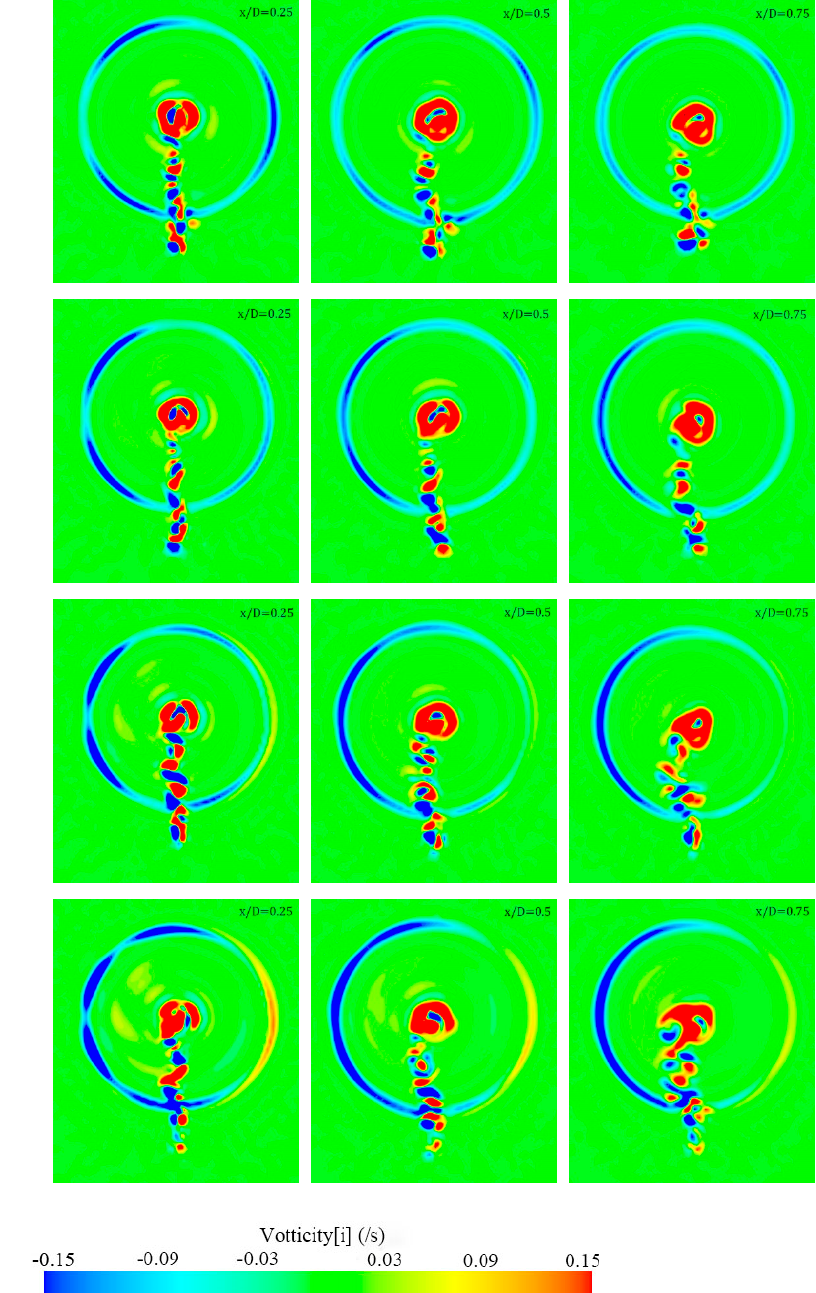
Figure 20. Instantaneous x-vorticities at different sections for four tilt angles.